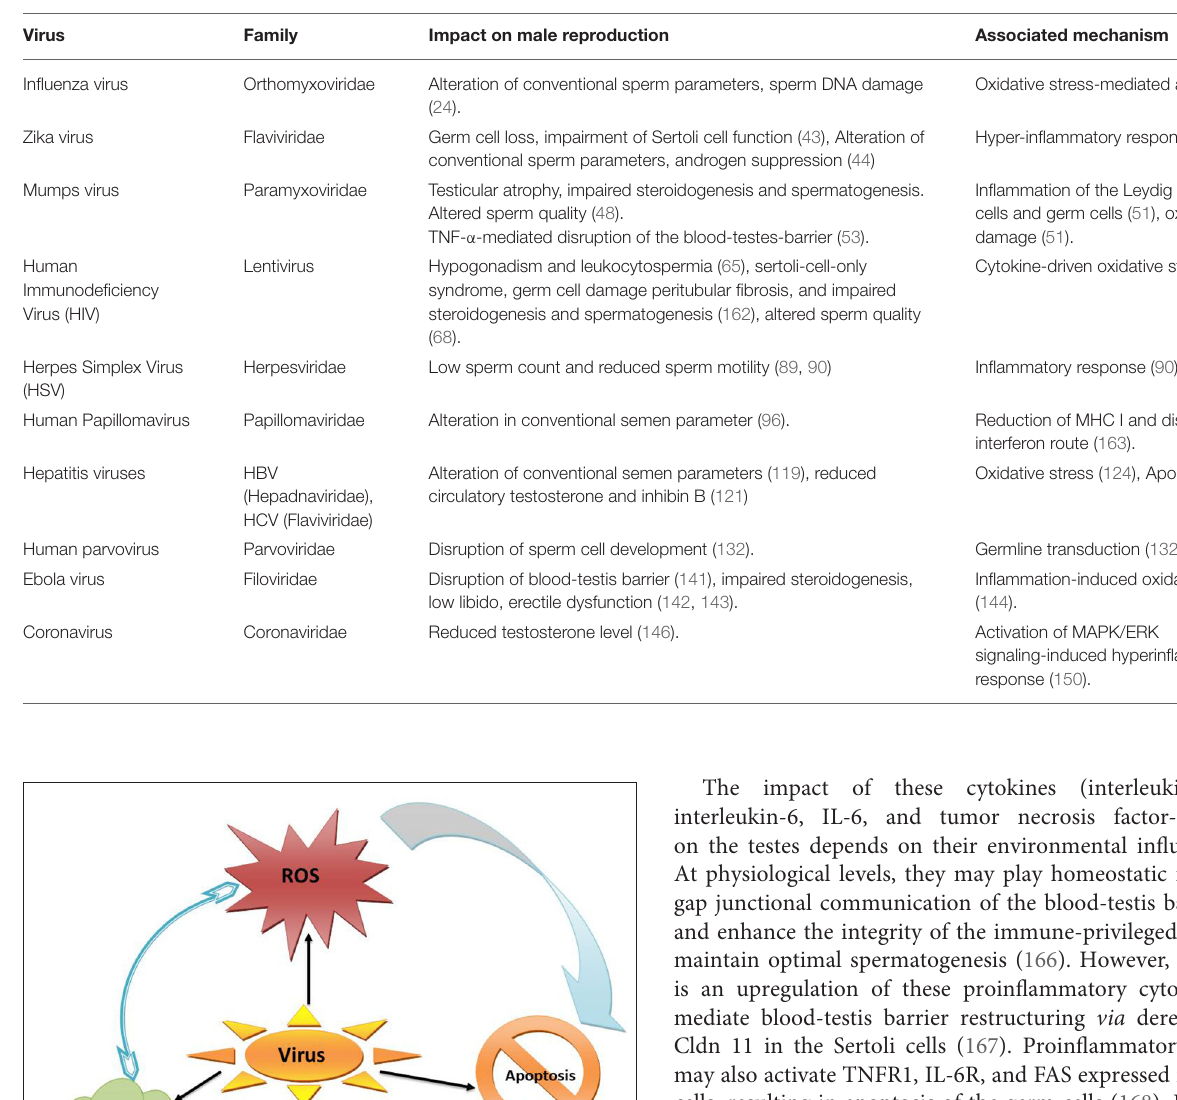
TABLE 1 | The impact and associated mechanism of viral infections.